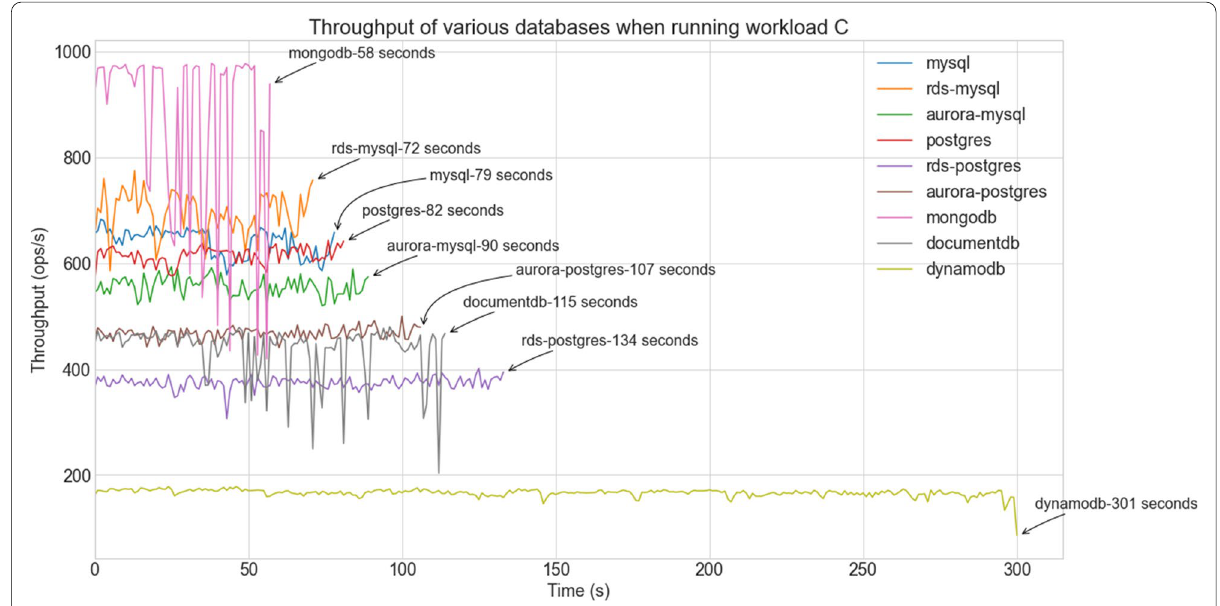
Fig. 6 Performance of databases with Workload‑c (Read & Write Intensive tasks)